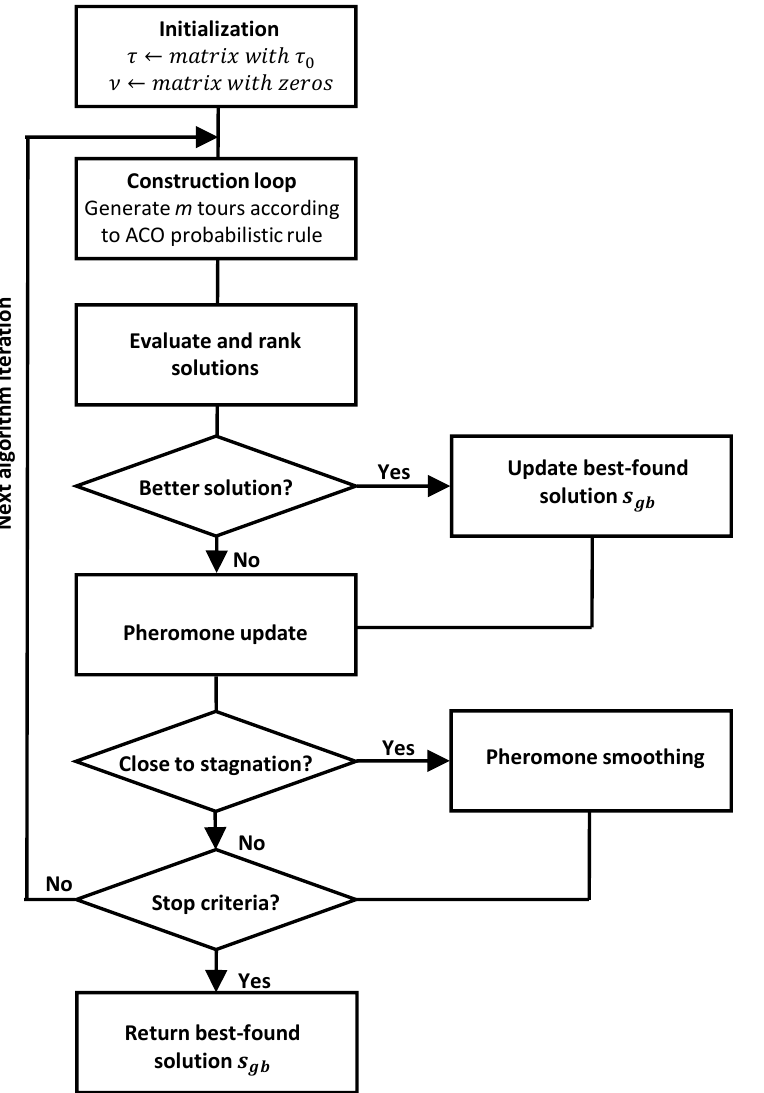
Figure 4. Algorithm flowchart of the proposed AS ps